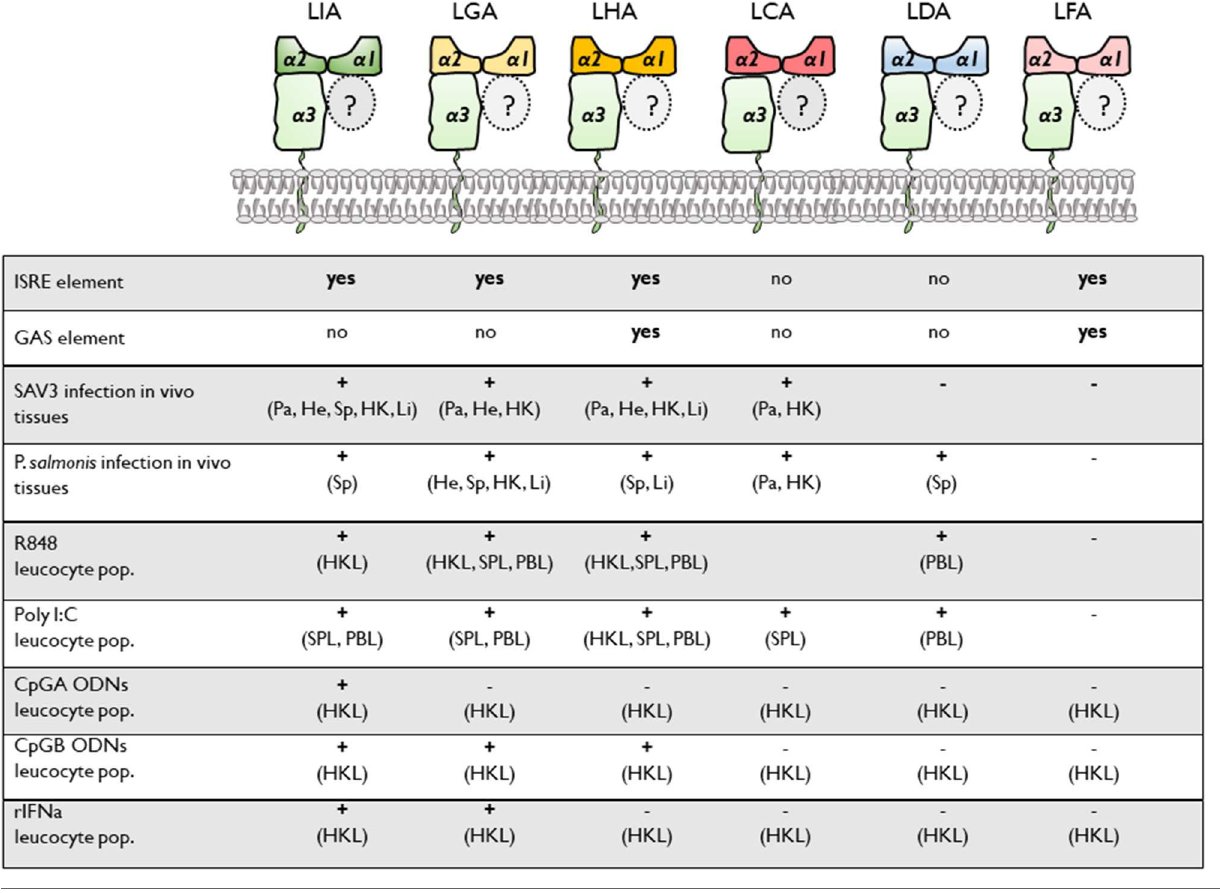
The six different L lineage genes are schematically represented on top, whether or not these molecules associate with B2-microglbulin remain to be determined. For SAV3 and P. salmonis infections ( + ) indicates significantly higher expression in the indicated tissues compared to PBS injected fish, (–) indicates no change in expression. Tissues examined are as follows; Pa, pancreas; He, heart; Sp, spleen; HK, head kidney; Li, liver. For R848, Poly I:C, CPG and rIFNa ( + ) indicates significant upregulation in the indicated leucocyte cultures (HKL, head kidney leucocytes; SPL, spleen leucocytes; PBL, peripheral blood leucocytes).